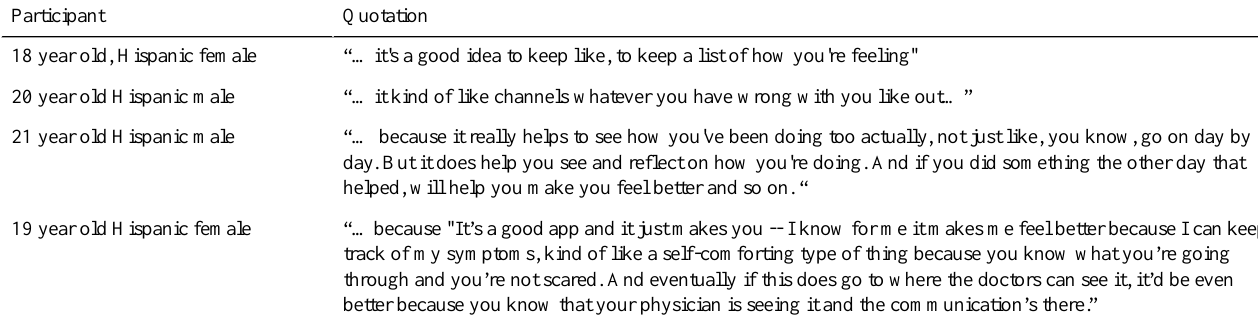
Table 5. Participants’reasons for recommending the use of the mOST application to